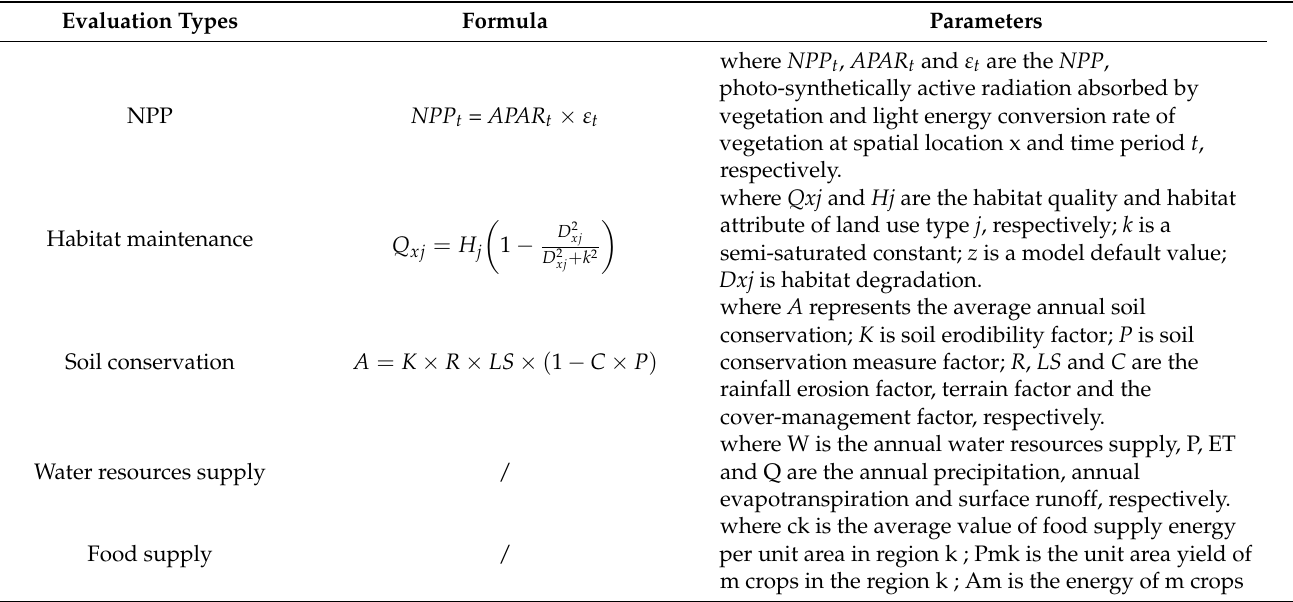
Table 1. Evaluation of ecosystem